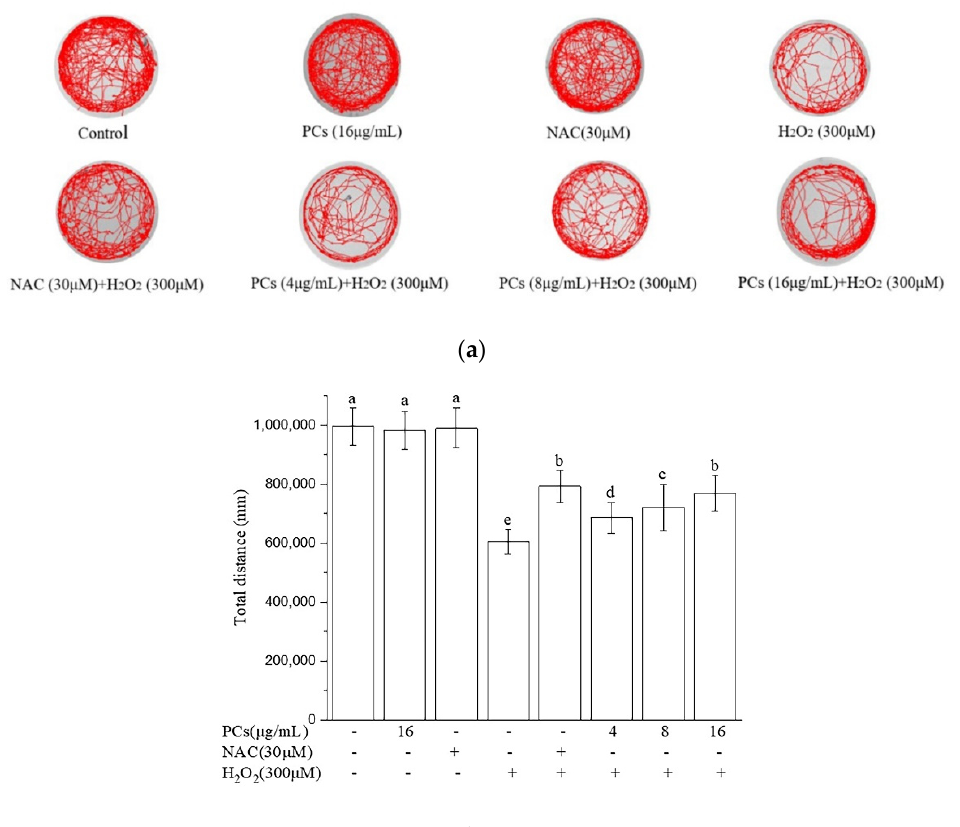
Figure 5. Effects of PCs on motility of H 2 O 2 -treated zebrafish larvae. ( a ) Typical patterns of swimming traces of zebrafish larvae in each group; ( b ) average total distance of zebrafish larvae in each group. Data are shown as the mean ± SD. All experiments were repeated three times. Values with different letters above are significantly different ( p < 0.05, one-way ANOVA).